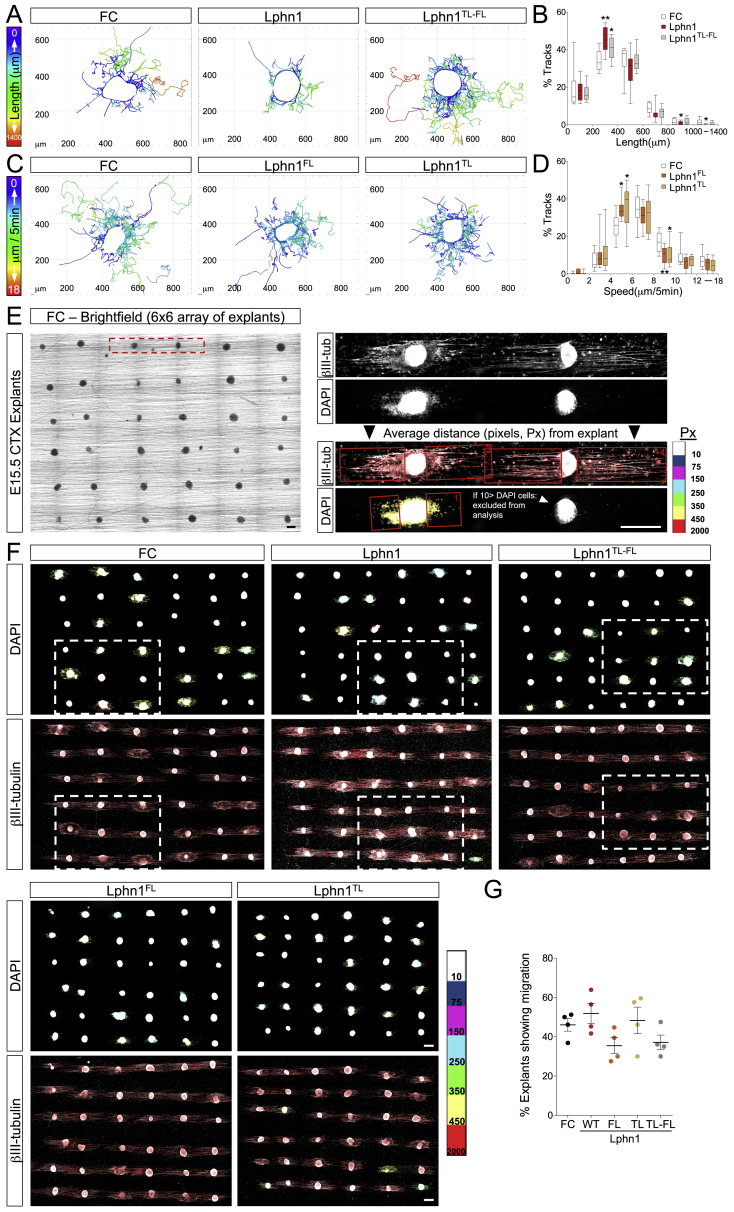
Latrophilin Interaction with Teneurin and FLRT Slows Down Cell Migration In Vitro, Related to Figure 4(A) Time-lapse analysis of cortical neurons migrating from E15.5 cortical explants on surfaces coated with FC (control), Lphn1 or Lphn1TL-FL proteins. Neurons were tracked (colored lines) and color-coded based on length of individual tracks. (B) Average length frequency distribution of all tracks in all conditions. n > 10 movies per condition. ∗p < 0.05 and ∗∗p < 0.01, one-way ANOVA test with Tukey’s post hoc analysis. The data are presented as whisker plots.(C) Time-lapse analysis of cortical neurons migrating from E15.5 cortical explants on surfaces coated with FC (control), murine Lphn1FL (Lec-Olf) or Lphn1TL (Lec-Olf) proteins. Neurons were tracked (colored lines) and color-coded based on speeds in individual tracks. (D) Average speed frequency distribution of all tracked neurons in all conditions. n > 10 movies per condition.∗p < 0.05 and ∗∗p < 0.01, one-way ANOVA test with Tukey’s post hoc analysis. The data are presented as whisker plots.(E) Scheme illustrating the organization of the 36 explants that are cultured per condition in each experiment and condition. The higher magnification of 2 explants shown on the right, shows growth and extension of axons after 2 days (DIV) (βIII-tubulin staining). DAPI staining illustrates the presence of explants that show migration of neurons (left explant, defined as explants showing more than 10 DAPI cells) while others only show extension of axons (right explant). Explants that show migration are quantified by drawing a rectangle on both sides containing the DAPI cells, based on the averaged distance from both sides, the explant is color-coded following the scale bar on the right. Same quantification applies for the extension of the axons. (F) Full images from one experiment with all conditions (control FC, Lphn1 and its mutant versions Lphn1FL, Lphn1TL and Lphn1TL-FL). Axon extension is not affected in any of these conditions, and occurs in all explants (βIII-tubulin). In contrast, DAPI staining reveals that only 40%–60% of the explants show exiting cell migration (defined as more than 10 DAPI+ cells exiting the explants). (G) Quantification of the percentage of explants with cell migration shown in (F). n = 4 experiments per condition as described in (E). Scale bar = 300 μm (E and F).